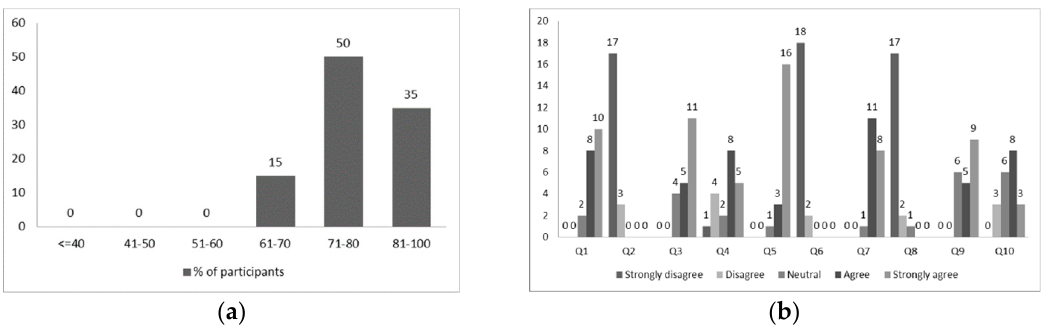
Figure 9. Results of the second evaluation with SUS: ( a ) SUS scores; ( b ) SUS questionnaire responses.